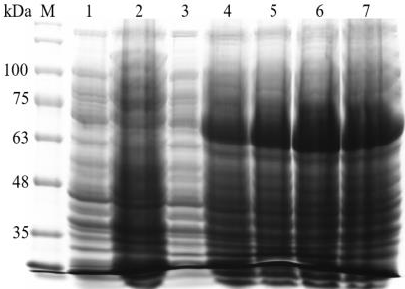
Figure 8. Induction of pET21a-BvAmylase expression. M: Protein standard; 1 and 2. BL21 (DE3) cells containing pET21a induced for 0 and 24 h; 3 – 7: BL21 (DE3) cells containing pET21a-BvAmylase induced for 0, 2, 4, 6, and 24 h.